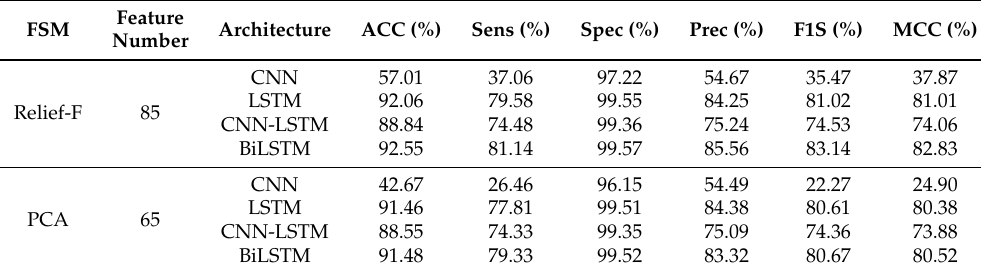
Table 10. Results for the test of the 4 Deep Learning architectures with the 85 first features ranked by Relief-f and 65 first features ranked by PCA.